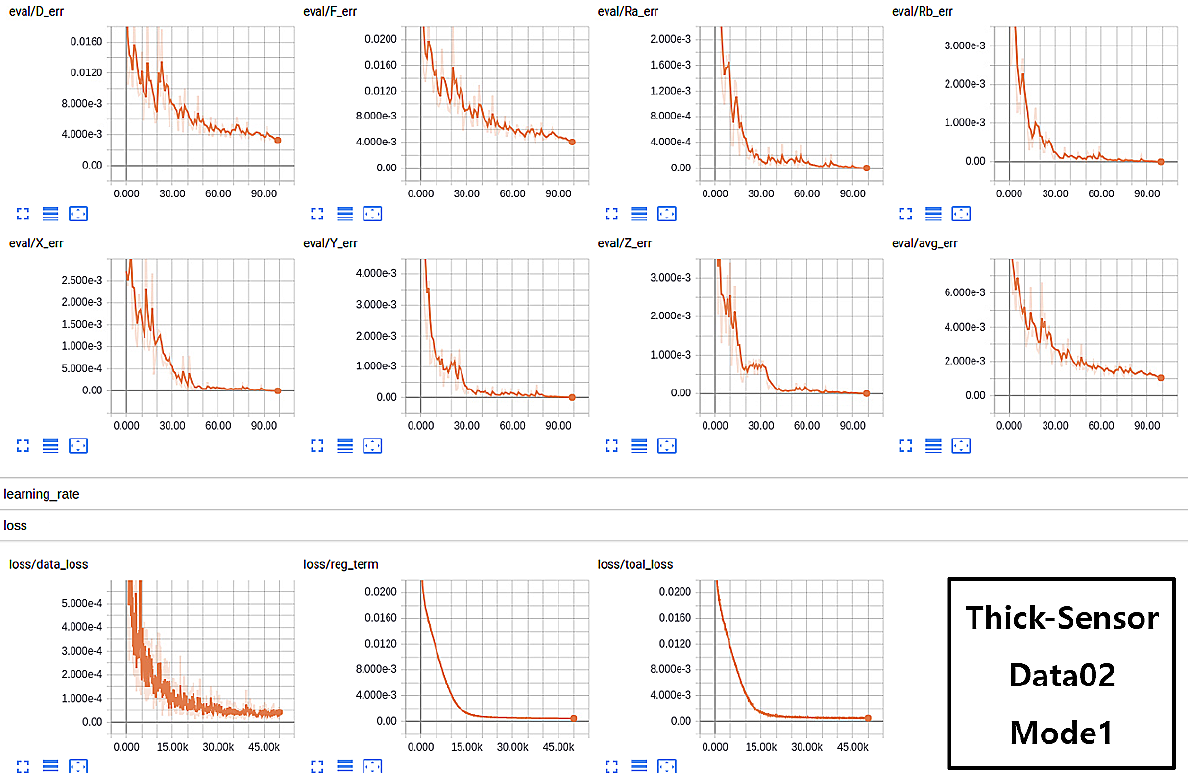
Figure 14. Successful case scenario of network training on thick sensor data (Data02) in the form of